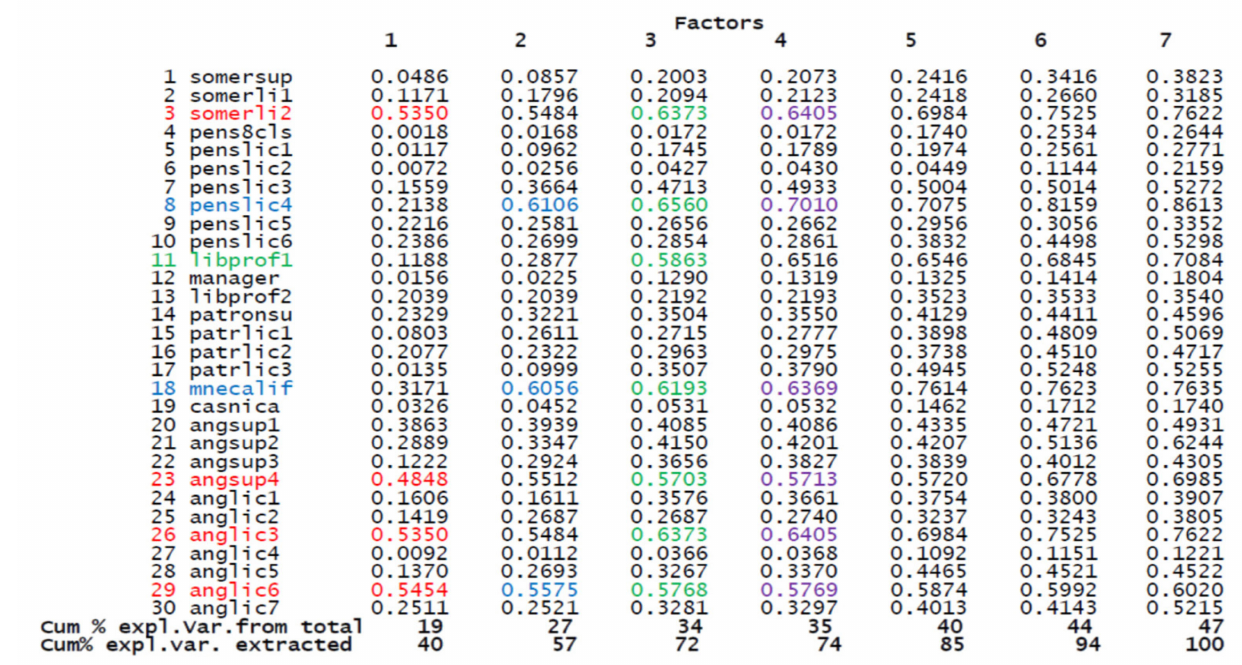
Figure 4. Matrix of the cumulated communalities of the seven factors extracted